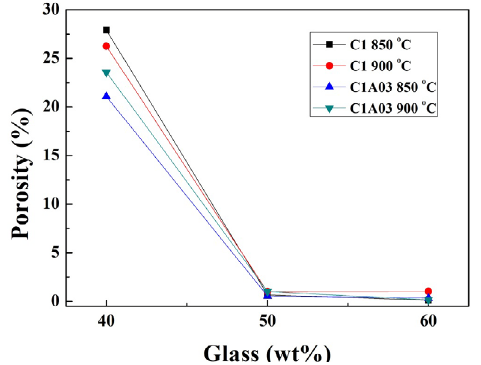
Fig. 6 Variation in porosities for Ca 0.7 Nd 0.2 TiO 3 added with various amounts of C1 and C1A03 glasses after sintering at 850 and 900 ℃ .